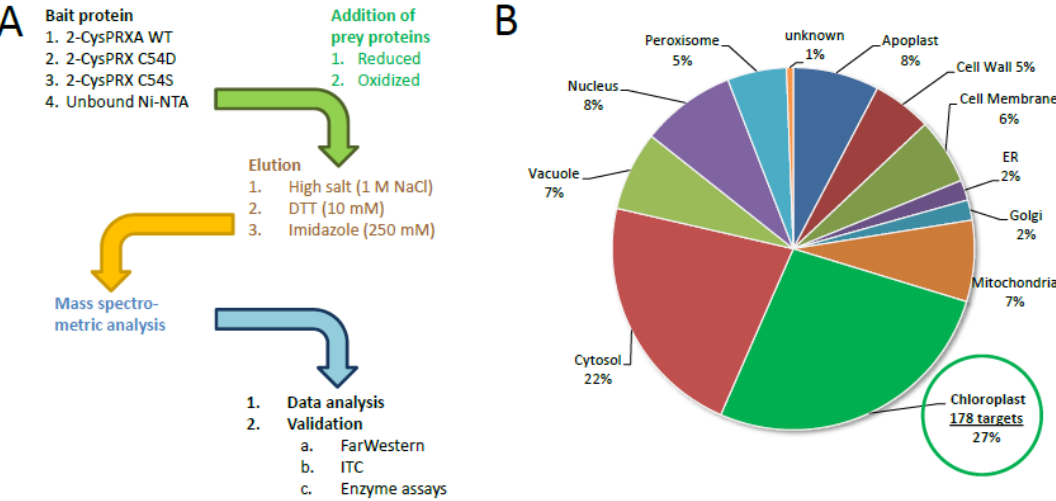
Figure 1. Workflow of the interactome study with 2-cysteine peroxiredoxin (2-CysPRX) variants and assignment of identified polypeptides to subcellular compartments. ( A ) Three variants of recombinant his6-tagged 2-CysPRXA (wild type (WT), C54S, C54D) were bound to Ni-nitrilotriacetic acid (NTA) sepharose. Unbound Ni-NTA-sepharose served as control. After binding of reduced or oxidized leaf proteins, washing, and step-wise elution, the peptides were identified by mass spectroscopy with technical replication. Data analysis employed UniRef90, MASCP Gator, and UniProt data bases. Some interaction partners were selected for further validation. ( B ) From 468 uniquely identified proteins compiled from all analyses, 178 or 27% were assigned to plastids. ER, endoplasmic reticulum; ITC, isothermal titration microcalorimetry; DTT,